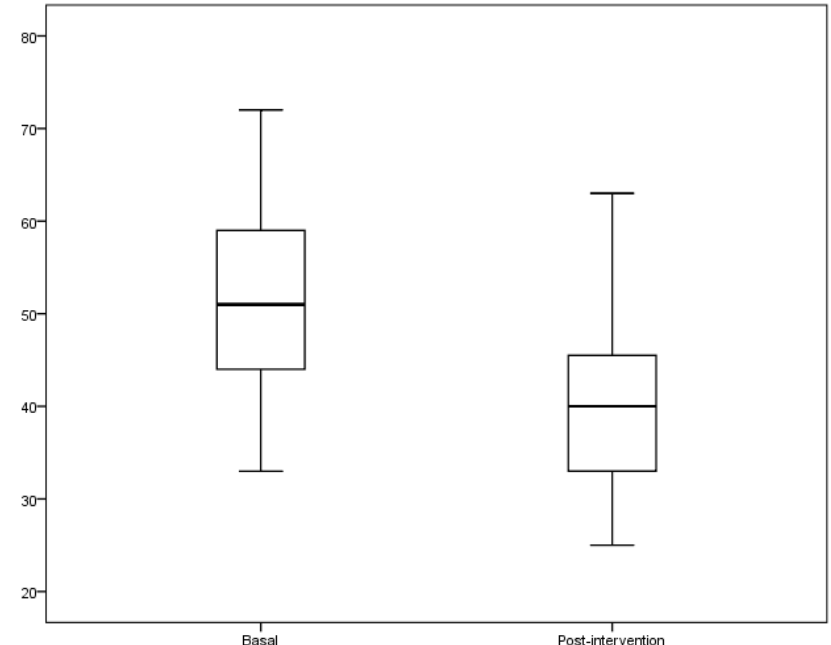
Figure 2. Mean ± SD score on self-rated negative attitudes to old age basal and post intervention. The graph shows the results of the community intervention in the score with “health promotion and self-care in the old age” workshop. The score shows a decrease statistically significant after intervention (baseline, 51 ± 10 vs. post-intervention, 40 ± 9, p < 0.001). Student’s t test, the values expressed as the mean ± standard deviation.